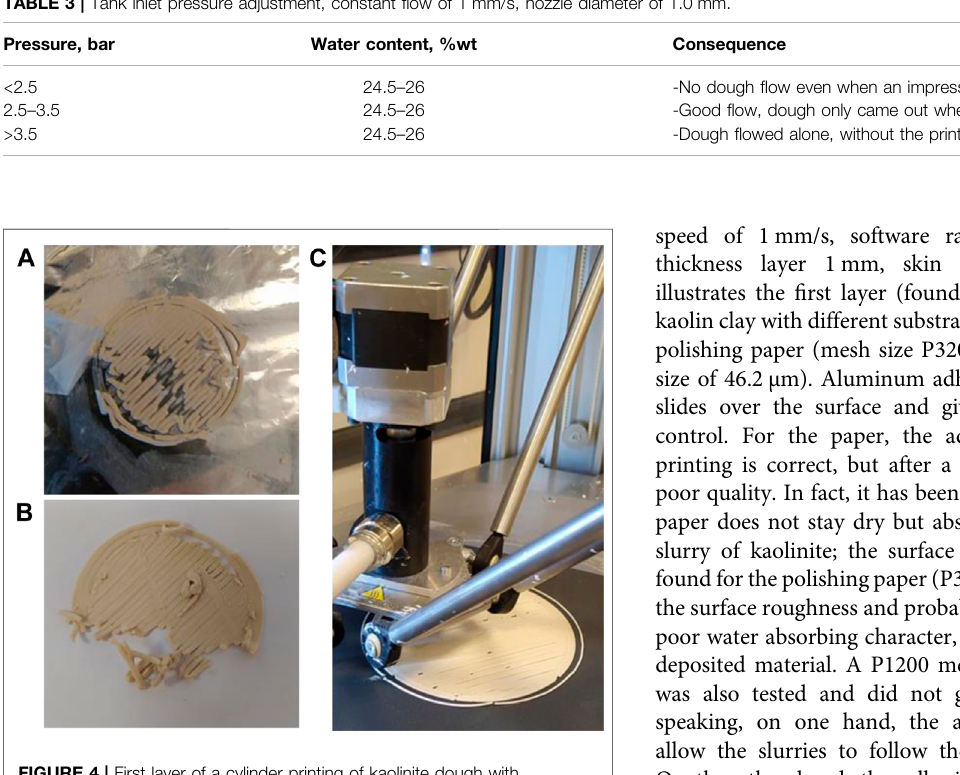
FIGURE 4 | First layer of a cylinder printing of kaolinite dough with different substrates (A) aluminium, (B) paper, and (C) polishing paper (mesh size